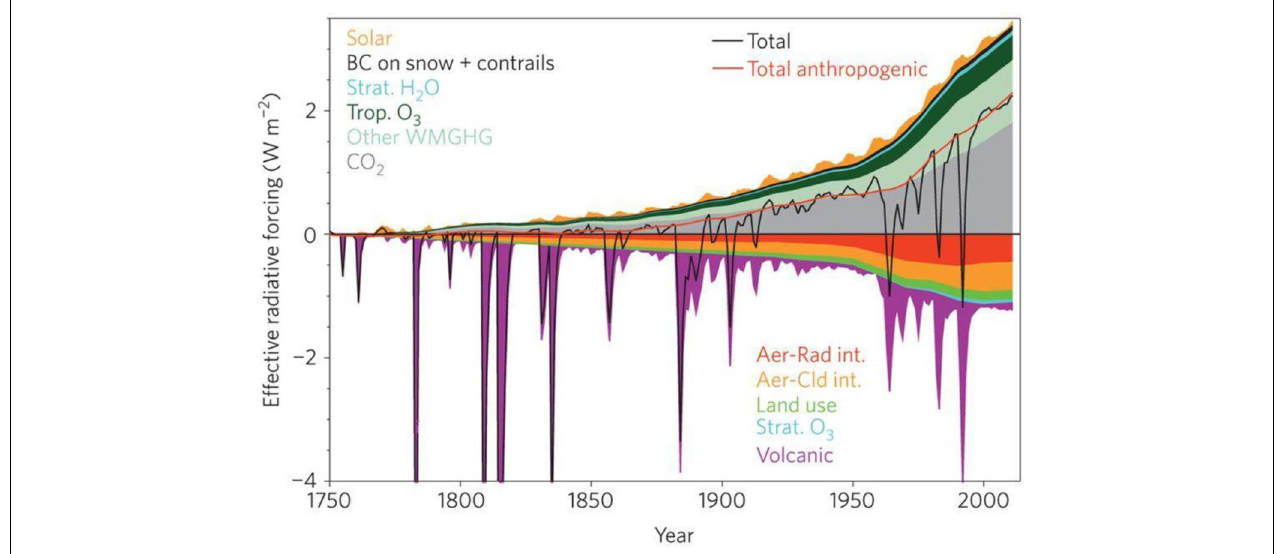
FIGURE 9 | An estimate of the radiative forcing of the climate system since 1750, including both natural (solar and volcanic) and anthropogenic climate forcings. Aer-Rad int. = aerosol–radiation interaction; Aer-Cld int. = aerosol–cloud interaction; BC = black carbon; Strat. = stratospheric; Trop. = tropospheric; WMGHG = well-mixed greenhouse gases. Reproduced from von Schuckmann et al. (2016, Figure